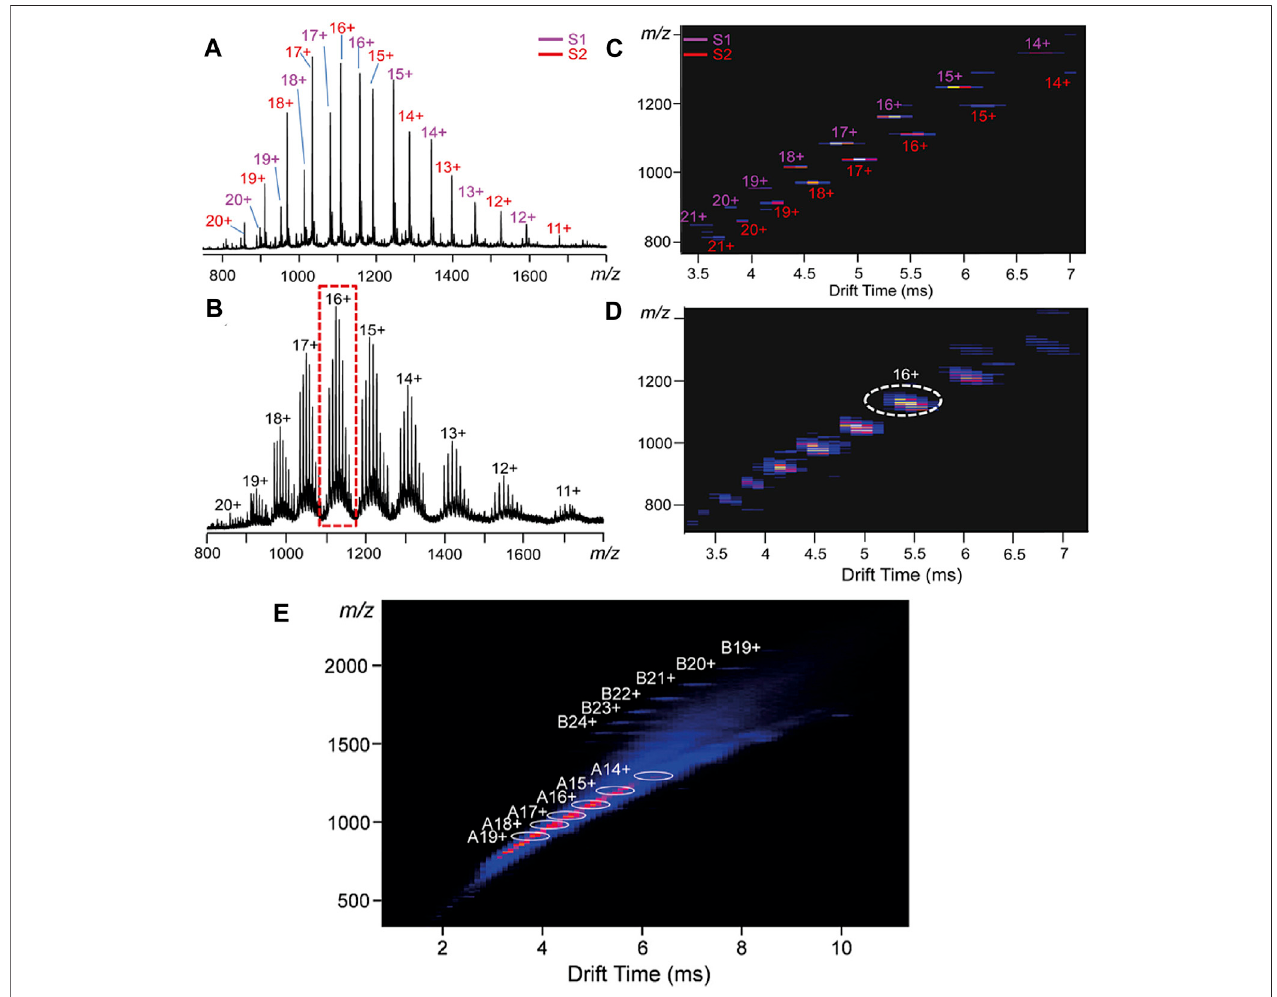
FIGURE 11 | IMS-MS allows the observation of intermediates in dynamic processes. The mixing of two snow fl ake assemblies over 5 days shows a clear change from (A) twoclearseries ofdistinct peaksattime (cid:2) 0to (B) 7peaksonday5representing thepopulation ofastatisticallymixedsetofligands. Additionally, thischangeis visible in the change in the ion mobility heatmap where (C) two clear chains of ions a time (cid:2) 0 become (D) mixed to create a larger peak positioned between the two chains (yellow circle) (Zhang et al., 2017). In other work, two clear sets of IMS-MS signals denote a lower m/z series of intermediates at different charge states (A-series) and a higher m/z series of fi nal assemblies at different charge states (B-series) (Wang et al., 2019).